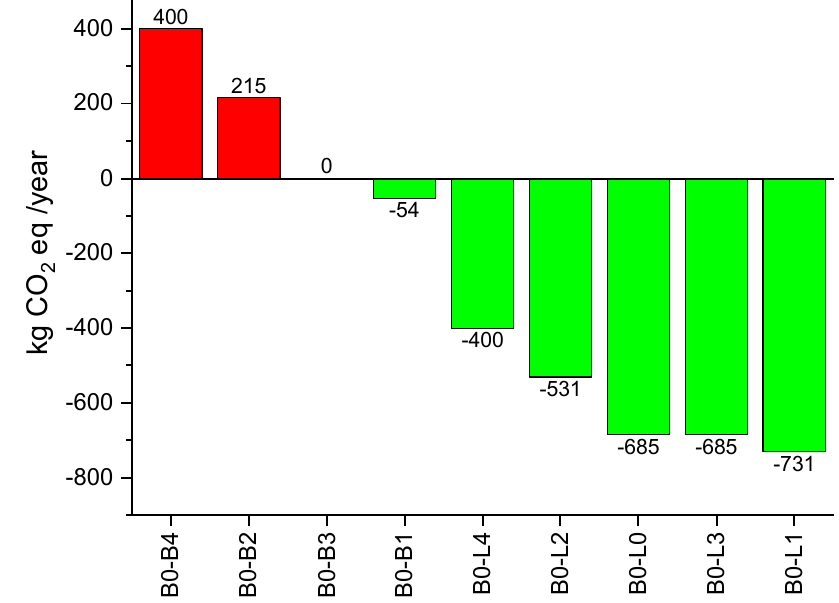
Figure 21. Difference between B0 and other configurations based on emission levels.